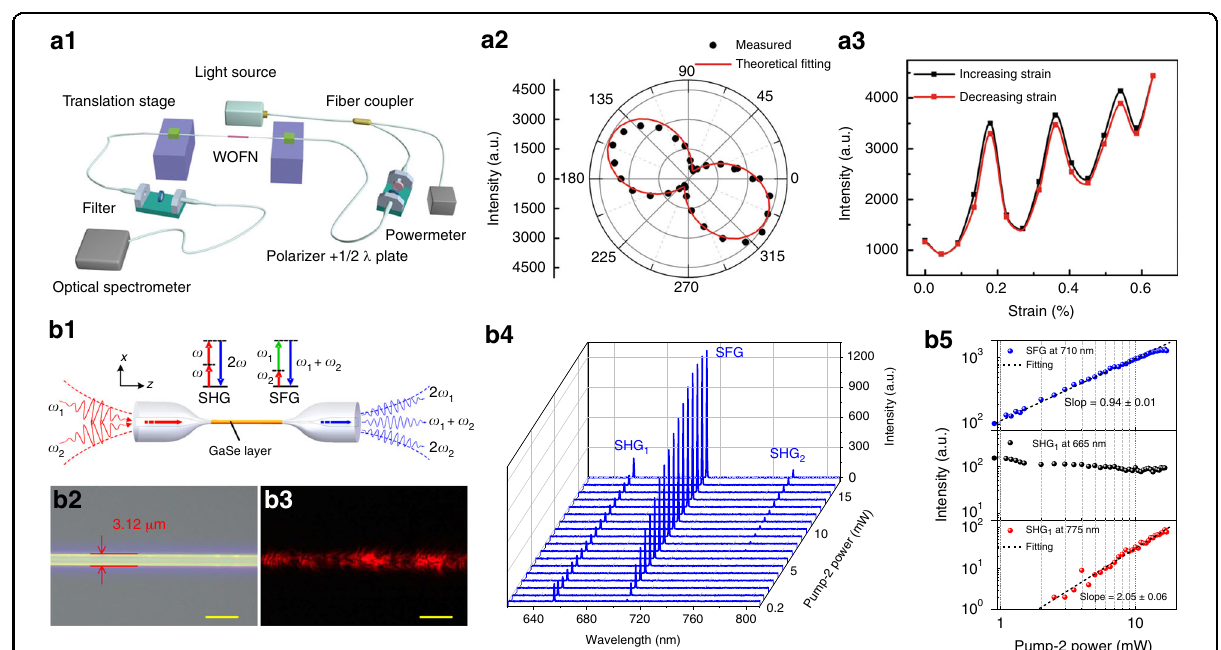
Fig. 9 Second-order nonlinear optics in hybrid micro fi ber-2D-materials structure. a Tunable and enhanced second harmonic generation (SHG) in hybrid WS 2 -MF waveguide 182 . Experimental setup for SHG measurement ( a1 ), output SHG depending on pump-light polarization ( a2 ) and output SHG intensity relating to loaded strain ( a3 ) 182 . b High-ef fi ciency SHG and sum-frequency generation (SFG) in GaSe nano fl akes functionalized MF 274 . Schematic of operations of SHG and SFG from GaSe-integrated MF ( b1 ), Optical microscopic images of samples ( b2 , b3 ), spectral evolution of SHG and SFG with variation of the Pump-2 light ( b4 ) and Log-log plots of the power dependences of SFG (top), SHG 1 (middle) and SHG 2 (bottom) by varying the incident power of Pump-2 ( b5 ) 274 . ( a1 – a3 ) and ( b1 – b5 ) from ref. 182,274 with permission by Springer Nature: Light: Science &